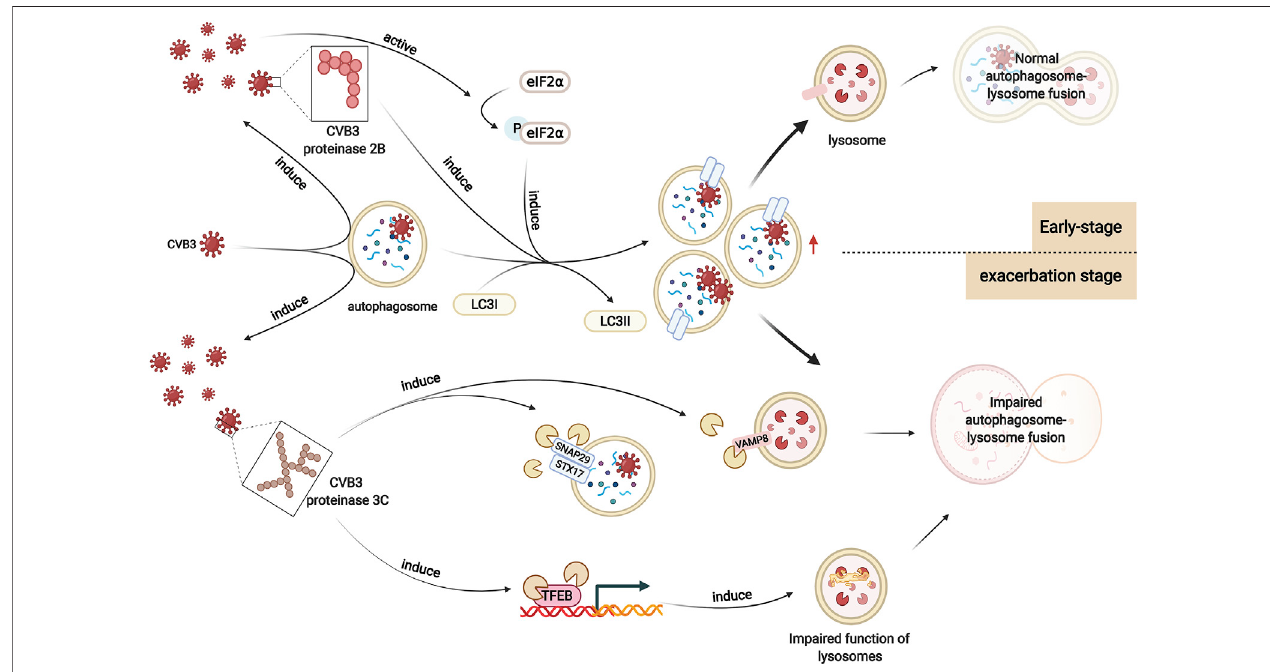
FIGURE 3 | Altered autophagy in viral myocarditis. In viral myocarditis, CVB3 exploits the double-membrane structure of autophagosomes to replicate. CVB3 promotes the formation of autophagosomes in host cells, which may be associated with enhanced eIF2 α phosphorylation. CVB3 proteinase 2B also plays a signi fi cant roleinthisprocess.AfterCVB3infection,autophagyisactivated.Intheearlystage,CVB3issequesteredbyautophagosomesanddeliveredtolysosomes,activatingthe autophagy positive-feedback pathway. Autophagosomes are subsequently degraded. However, as infection worsens, CVB3 proteinase 3C contributes to the cleavage of autophagy receptors that play a vital role in autophagosome-lysosome fusion. Moreover, CVB3 also targets TFEB for proteolytic processing by CVB3 proteinase 3C to disrupt host lysosomal function. Autophagosome-lysosome fusion is impaired, which affects the degradation of autophagosomes, enhancing viral